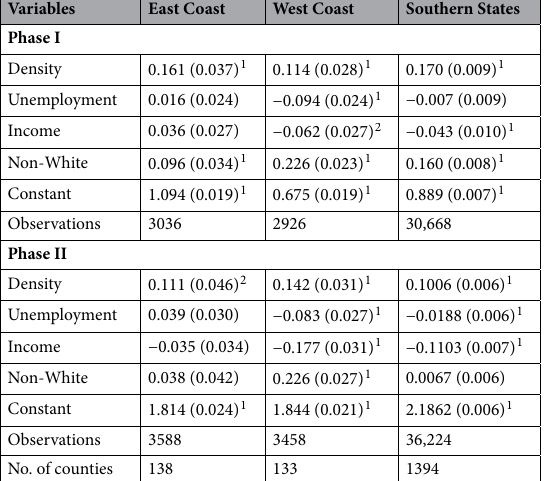
Table 1. Results of the causal analyses performed with random effects models. The central value and the robust standard errors (in brackets) are given for the variables that were considered in the analyses.The 1 p < 0.01 2 p < 0.05 p -values are marked as: ,